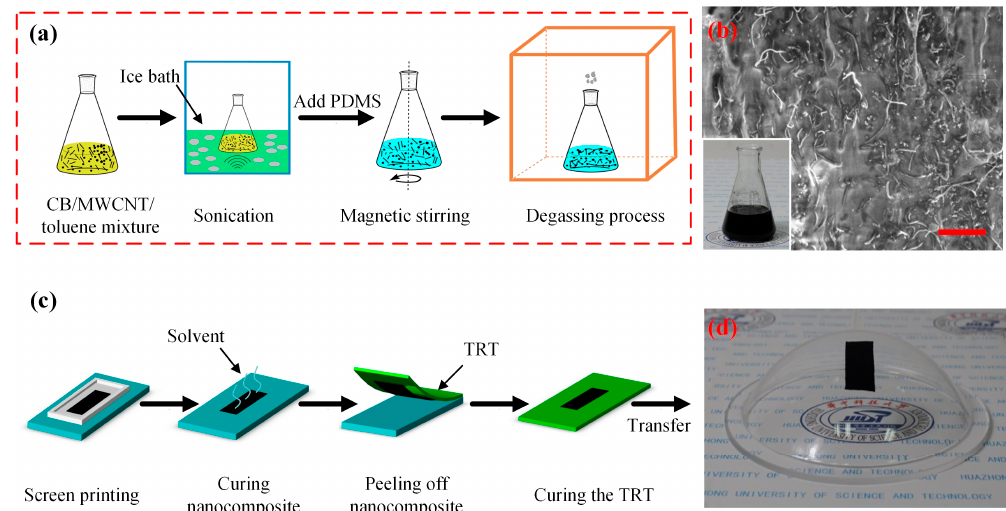
Figure 1. Schematic diagram of ternary nanocomposite preparation, fabrication and transfer printing process. ( a ) Synthesis process of nanocomposite; ( b ) SEM image of prepared nanocomposite